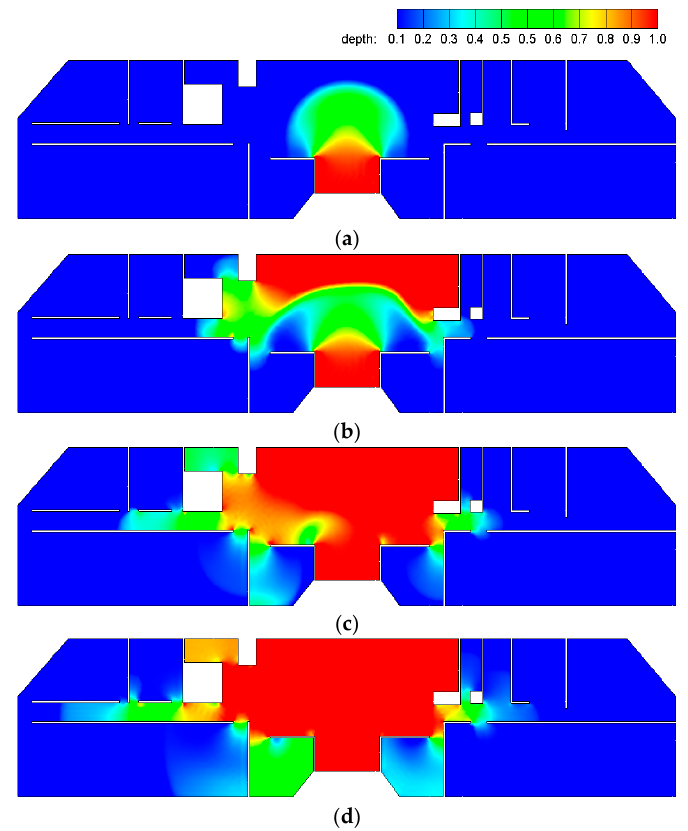
Figure 6. Configurations of inundation depth for the ground floor (unit of contour legend: m); ( a ) t = 4 s; ( b ) t = 12 s; ( c ) t = 18 s; ( d ) t = 24 s.